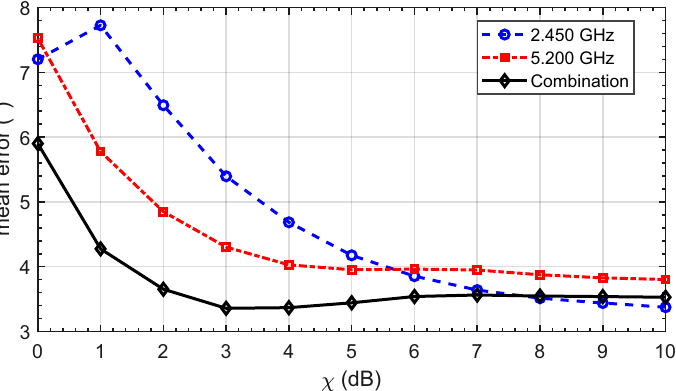
Figure 11. Mean DoA estimation error for D =